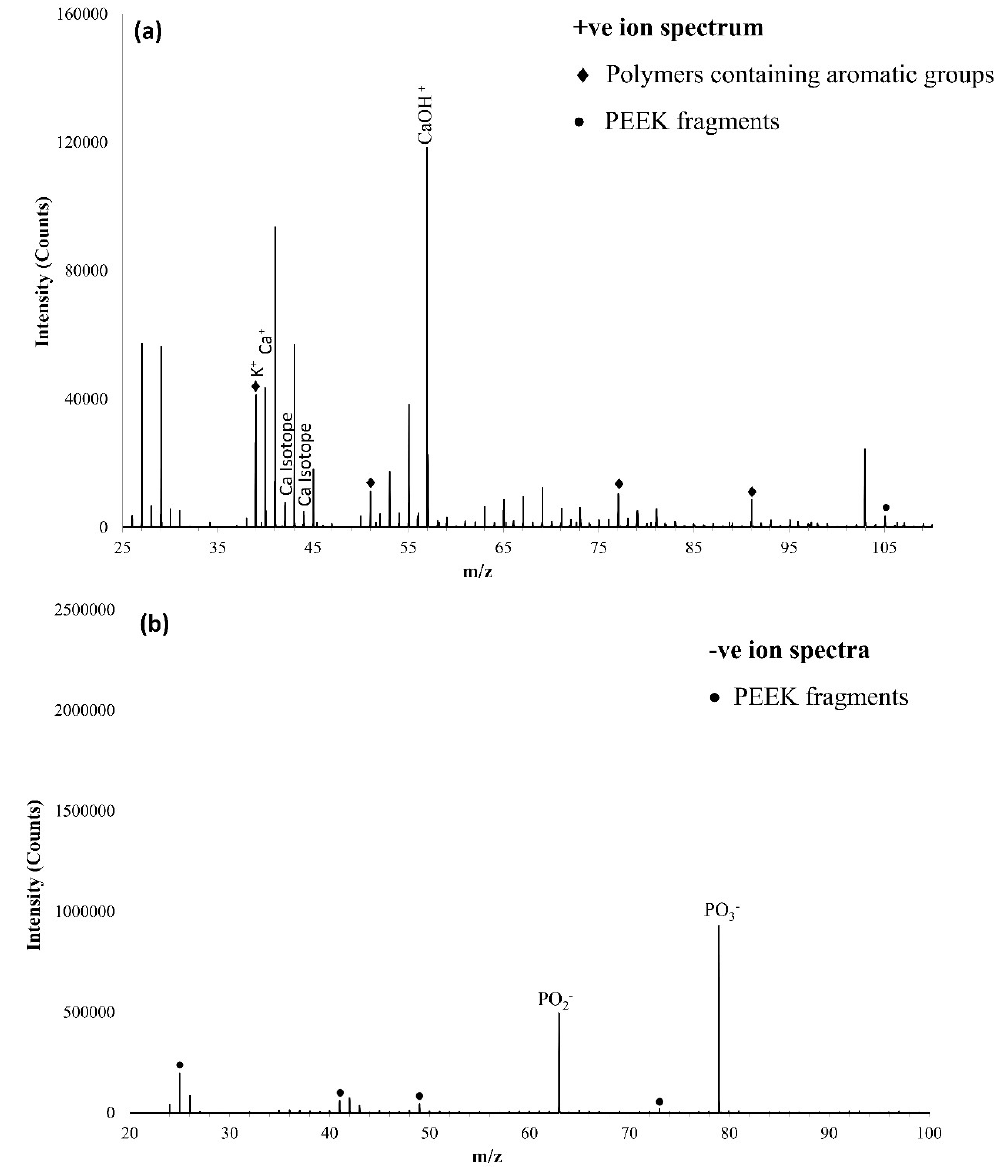
Figure 11. ToFSIMS survey spectra for ( a ) positive ions HA10, ( b ) negative ions HA10.